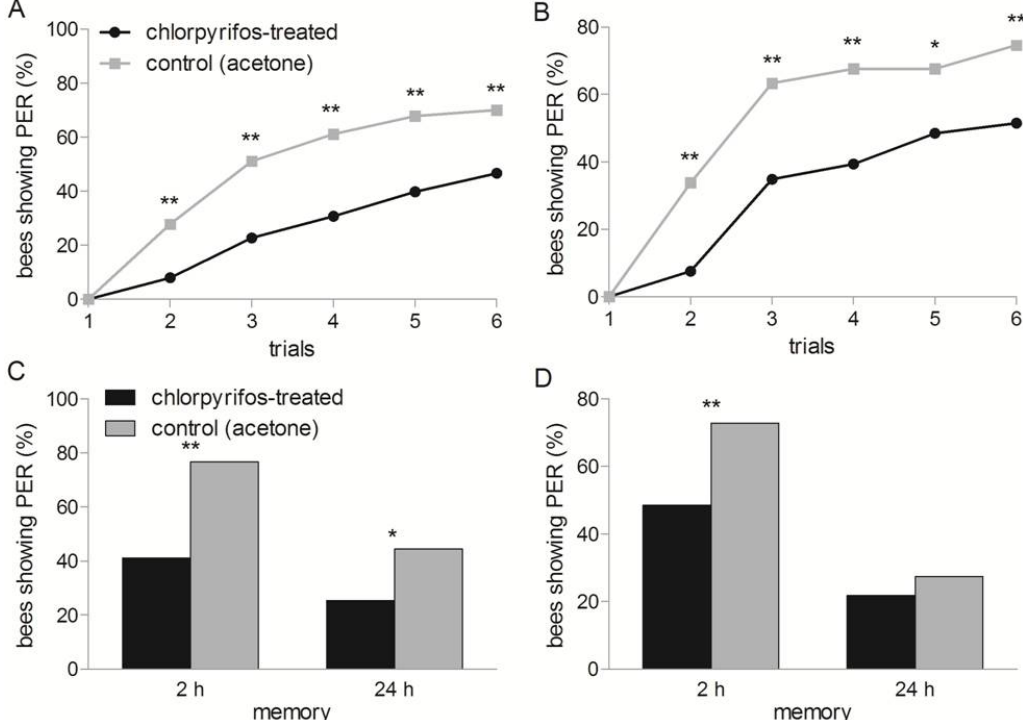
Fig 3. Sublethal doses of chlorpyrifos impair learning and memory performances in A . cerana . Learning performances were significantly impaired in chlorpyrifos treated A . cerana honey bees after 2 h (A), and 24 h (B) exposure. Among honey bees exposed for 2 h, honey bees showed significantly impaired memory performances 2 and 24 h after six training trials ( C); among honey bees exposed for 24 h, honey bees showed significantly impaired memory performances 2 h, but not 24 h after six training trials ( D). Control bees received acetone. Asterisks denote significant differences: one, p<0.05; two,